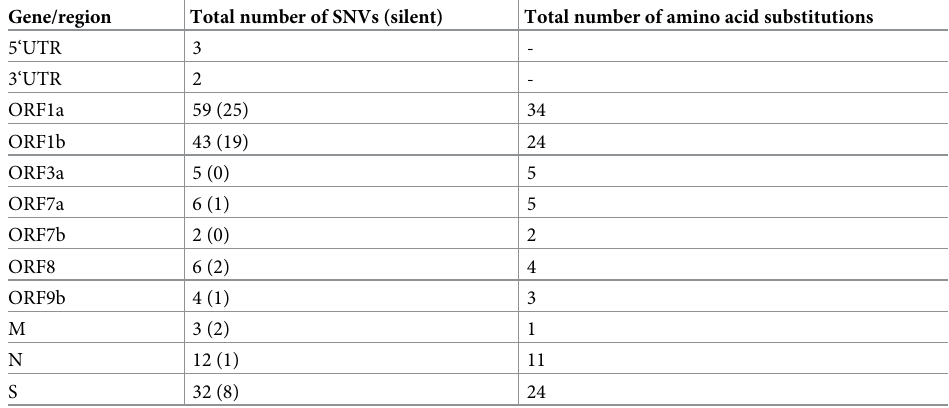
Table 3. Genome distribution of the total number of identified nucleotide and amino acid substitutions among the SARS-CoV-2 (n = 39) samples from Uzbekistan.